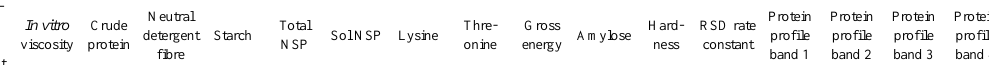
Table 5. Correlation between chemical and physical parameters of wheat Specific